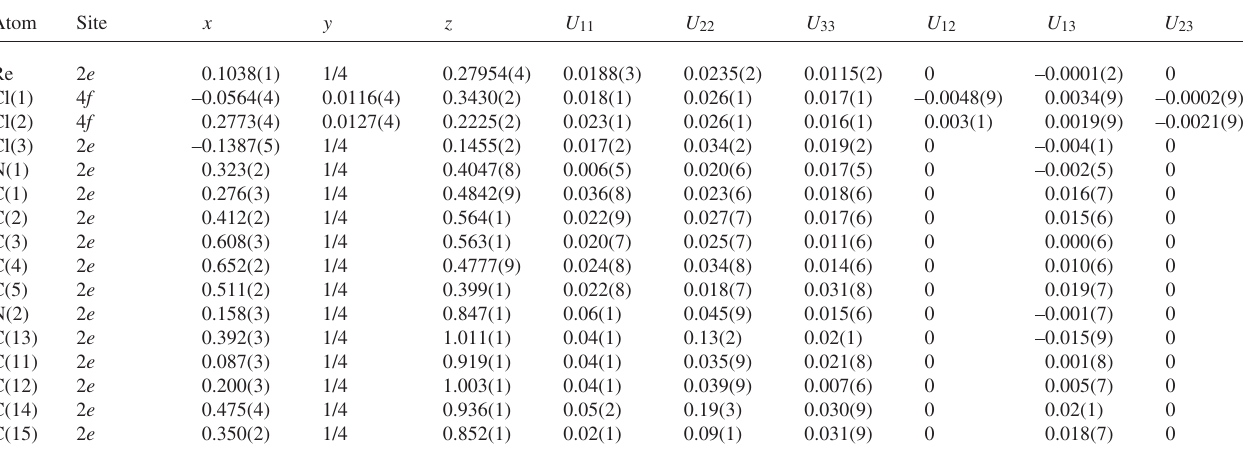
Table 3. Atomic coordinates and displacement parameters (in Å 2 )